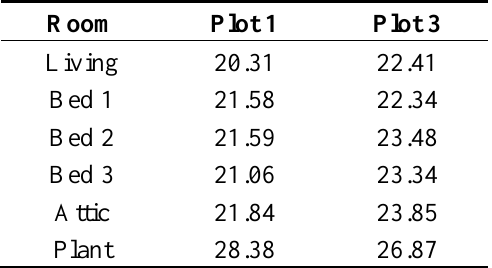
Table 9. SC3 mean